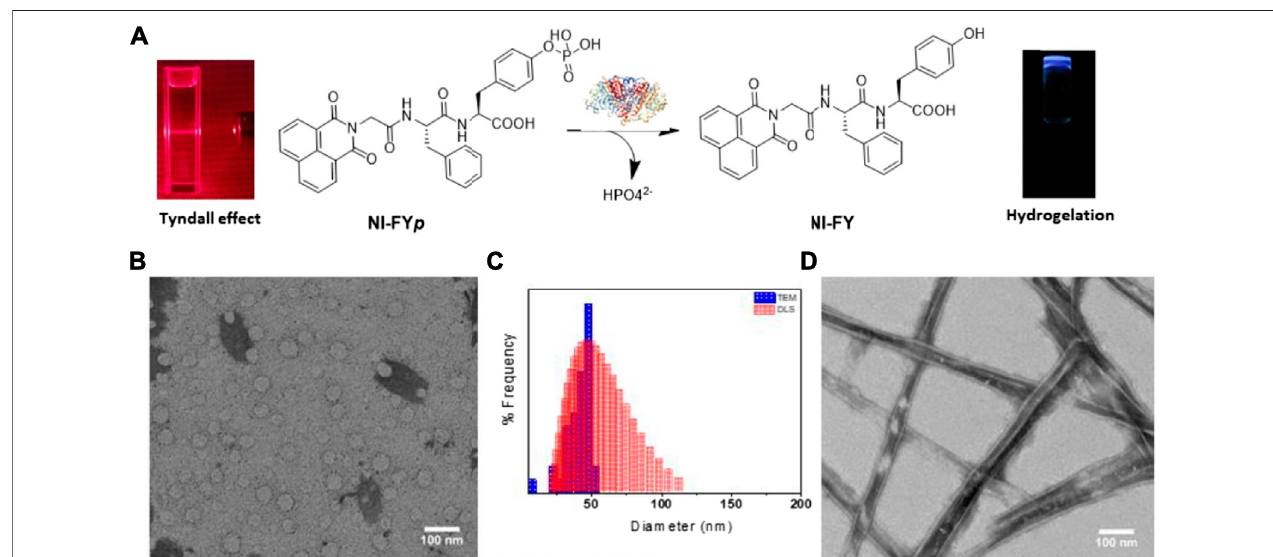
FIGURE 3 | (A) The illustration of self-assembly NI-FY p dipeptide nanostructures which transformed from spherical nanoparticles into a hydrogel during the enzymatic catalytic process; (B) TEM image of NI-FY p nanoparticles in Tris-buffer (10 mM); (C) particle size distribution histogram of NI-FY p (10 mM) nanoparticles by TEM and DLS measurements; (D) TEM images of NI-FY p treated with 10 U of ALP (Chakravarthy et al.,